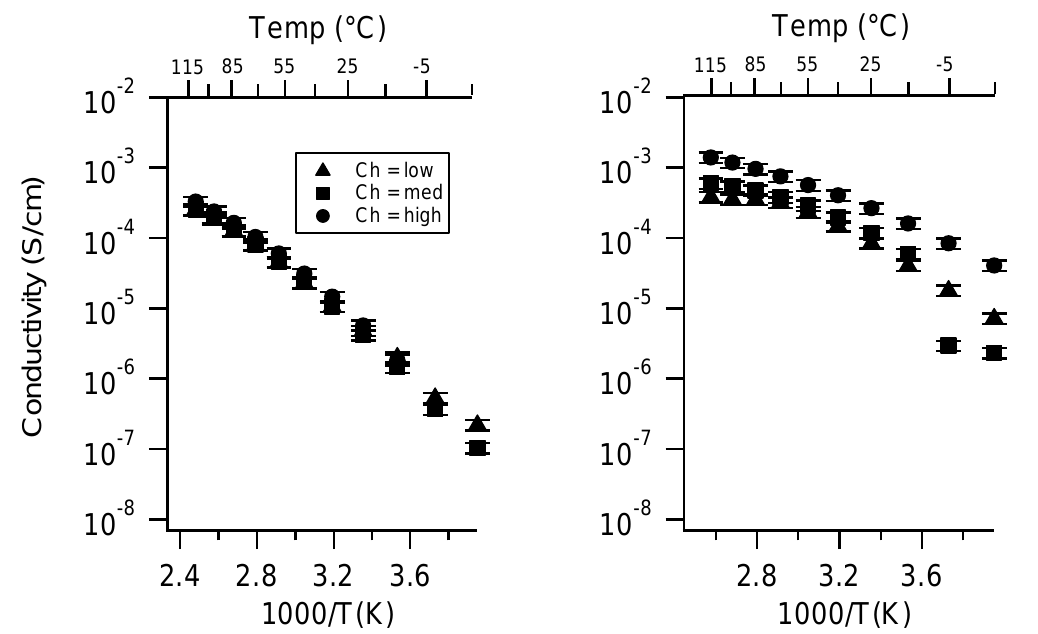
Figure A18. Conductivity as a function of charge density for PEGDMA1000_SSK (left) and PTHFDA1000_STFSIK (right) SIPEs swelled with ECPC. Temperatures ranged from − 20 °C to 115 °C.